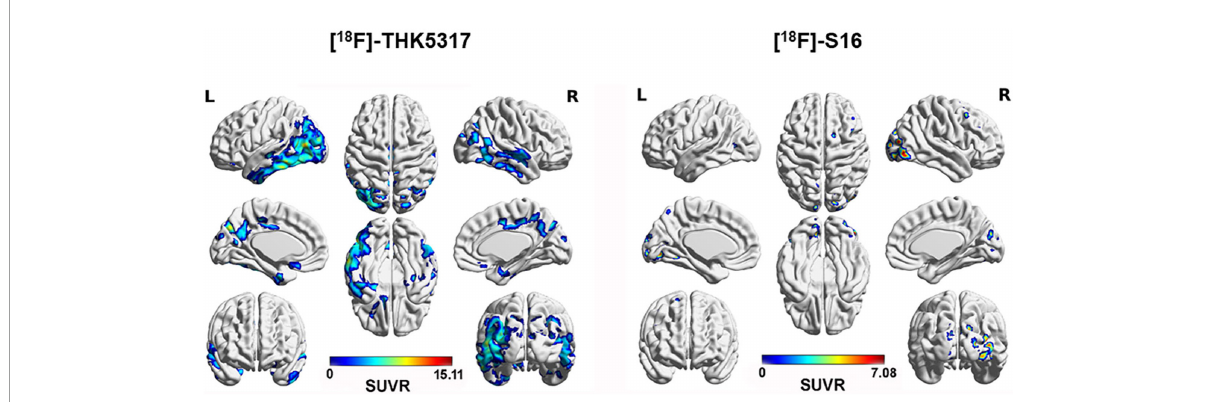
FIGURE3 Surface projection maps for mean SUVR images comparing AD and HC subjects for [ 18 F]-THK5317 and [ 18 F]-S16. AD patients showed significantly increased cortical retention of [ 18 F]-THK5317 in the bilateral temporal cortex, occipital cortex, PCC/precuneus, and prefrontal cortex. For [ 18 F]-S16, increased radioactivity retention was observed in the bilateral occipital cortex, right parietal cortex, and right lateral frontal cortex.